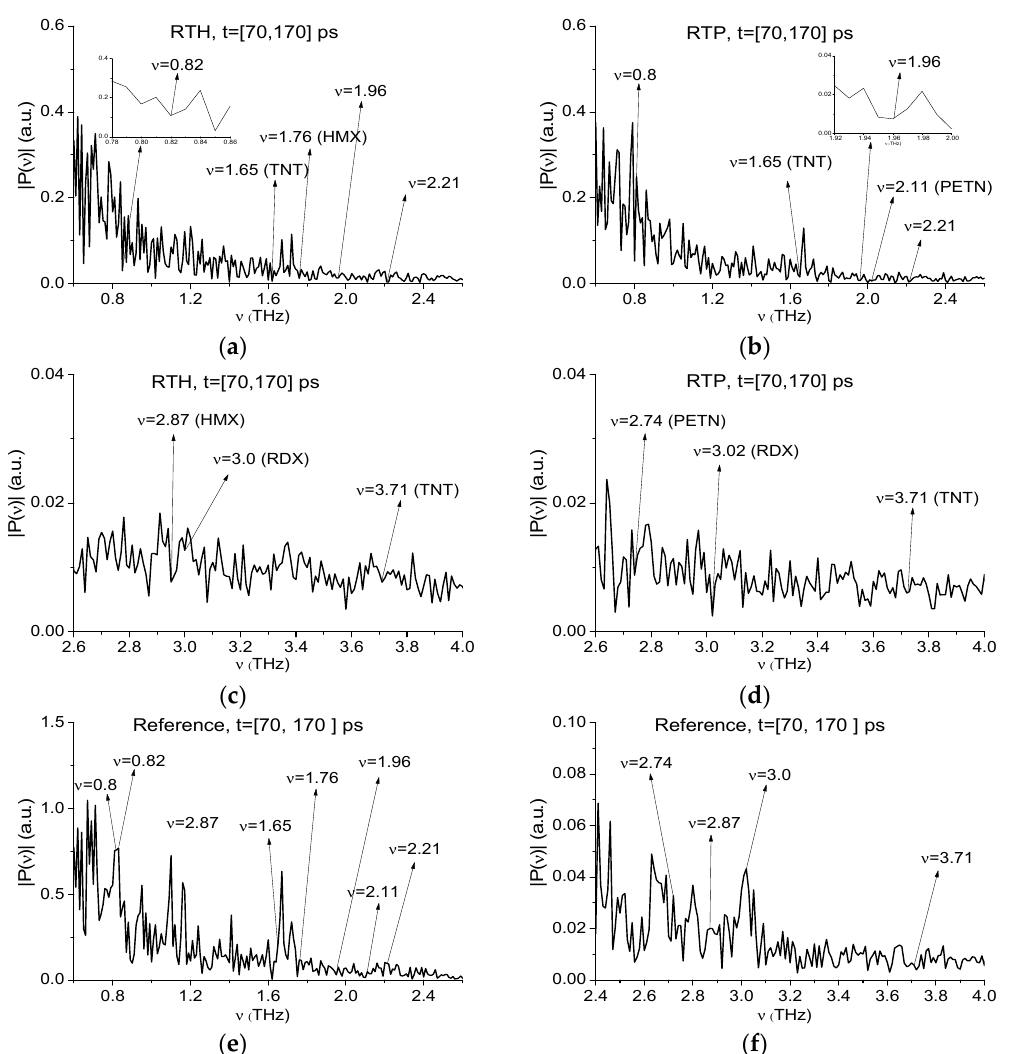
Figure 18. Spectra of the RTH ( a,c ), RTP ( b,d ) signals and reference ( e,f ) computed in the time interval t = [70, 170] ps, in the frequency ranges ν =[0.6, 2.6] THz ( a,b,e ) and [2.6, 4.0] THz ( c,d,f ).